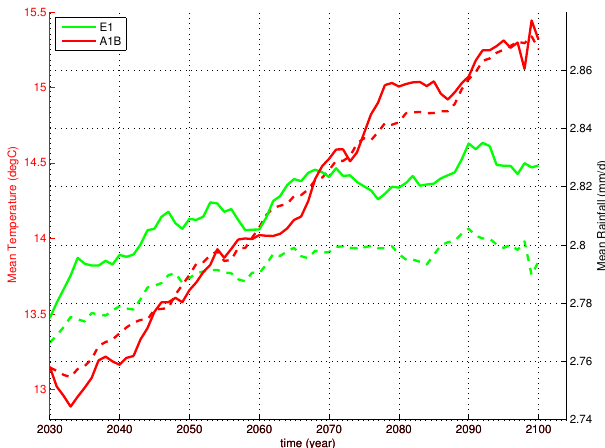
Fig. 5. 2030–2100 zoomed in time evolution of 5-yr running means for globally-averaged near surface temperature (left axis dashed lines) and precipitation (right axis solid lines) for the A1B (red) and E1 (green) scenarios.